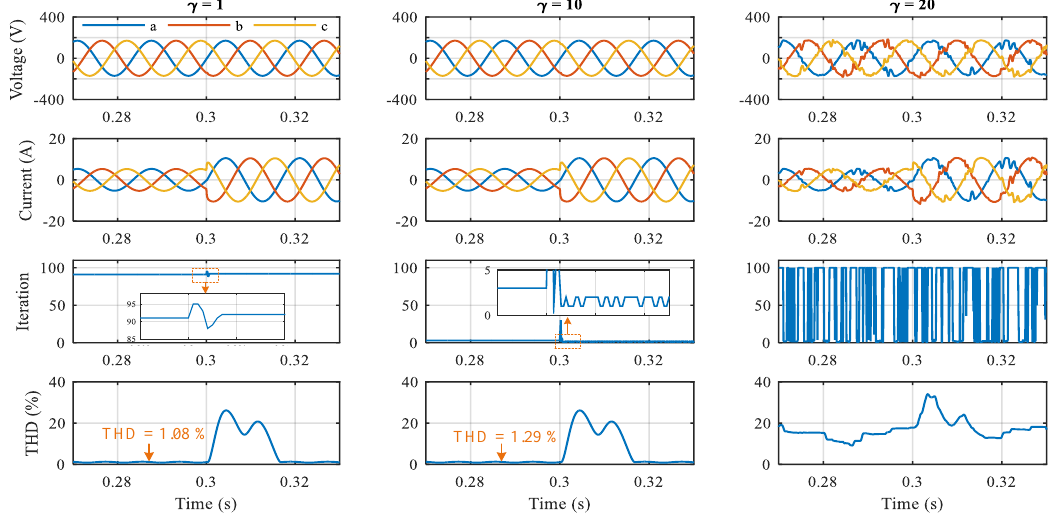
Figure 6. Effect of learning rate on the control performance of the converter .